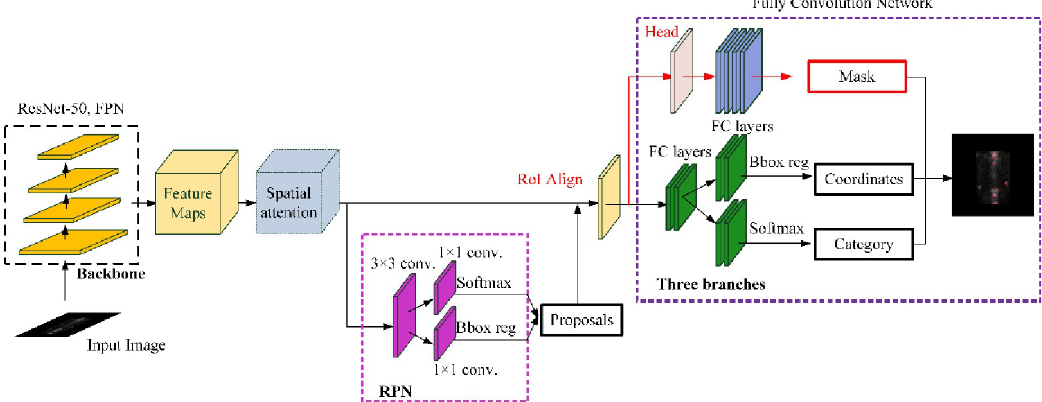
Fig 7. The architecture of the Mask-RCNN based segmentation network with spatial attention